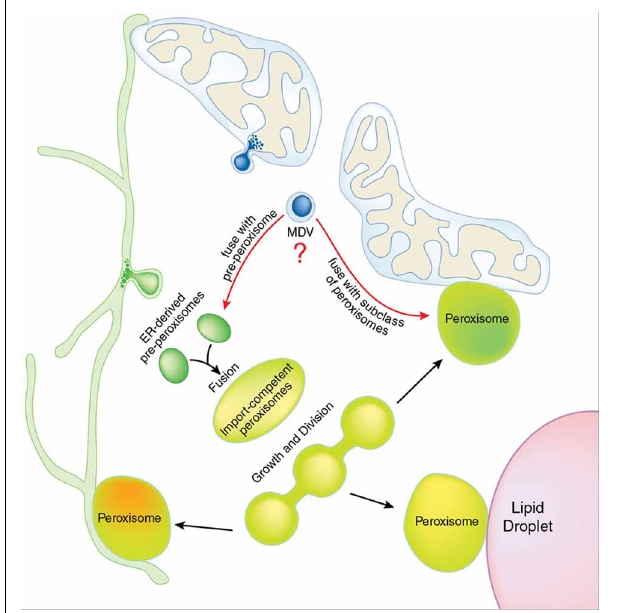
FIGURE 1 | Potential contribution of MDVs to peroxisomal biogenesis and functional specialization. Pre-peroxisomes bud from the endoplasmic reticulum (ER, in green), carrying subcomplexes of the import machinery. Fusion between ER-derived pre-peroxisomes results in an import competent peroxisome that continues to grow and mature. Elongation and division of peroxisomes occurs throughout the life of peroxisomes, in response to cellular conditions. Mitochondria are shown (blue) with a mitochondrial derived vesicle (MDV) emerging, containing both inner and outer mitochondrial membranes. Both membranes were observed in immuno-electron microscopy analysis of MAPL-positive vesicles, indicating that double-membrane bound vesicles target the peroxisome (Neuspiel et al., 2008). Since MAPL containing MDVs fuse with only a sub-population of peroxisomes, we envision two possible fates (indicated by red arrows). First, MDVs may fuse with an early pre-peroxisomal pool. MAPL was seen to fuse with peroxisomes containing CFP-SKL (Neuspiel et al., 2008; Braschi et al., 2010), indicating that MDVs fuse with an import-competent class of organelles. From this we predict that MDV fusion would occur downstream of ER-derived pre-peroxisomal fusion. Alternatively, MDVs could fuse with a functionally distinct subclass of peroxisomes, which are illustrated by different shading within mature peroxisomes. A number of direct contact sites are shown between organelles, which have been characterized in many cellular conditions (see text for